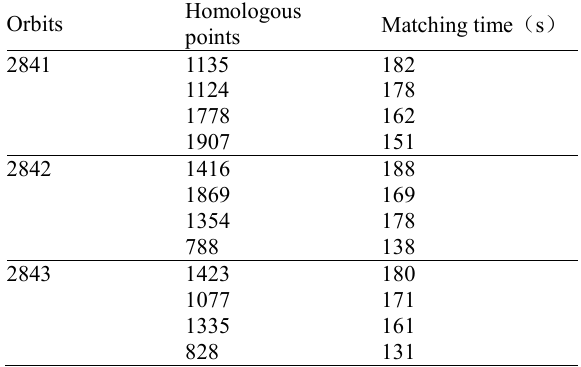
Table 2. The number of homologous points and matching time